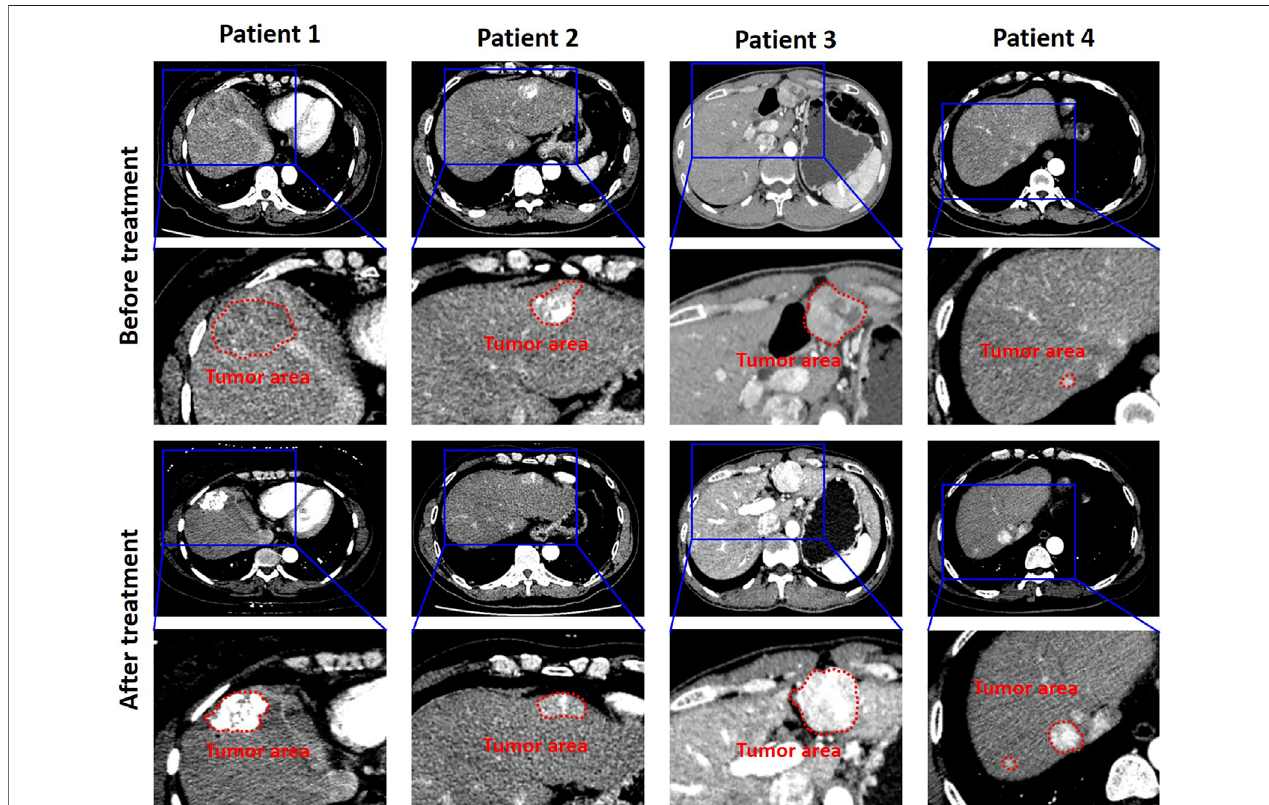
FIGURE2| CTimageswerecollected7 daysbeforetreatmentand1 monthaftertreatment,respectively.Themeasurementrangewasthelongestdiameterofthe enhanced lesion in the tumor area. The tumor area of validation cohort with HCC of TACE therapy is shown in the red box.